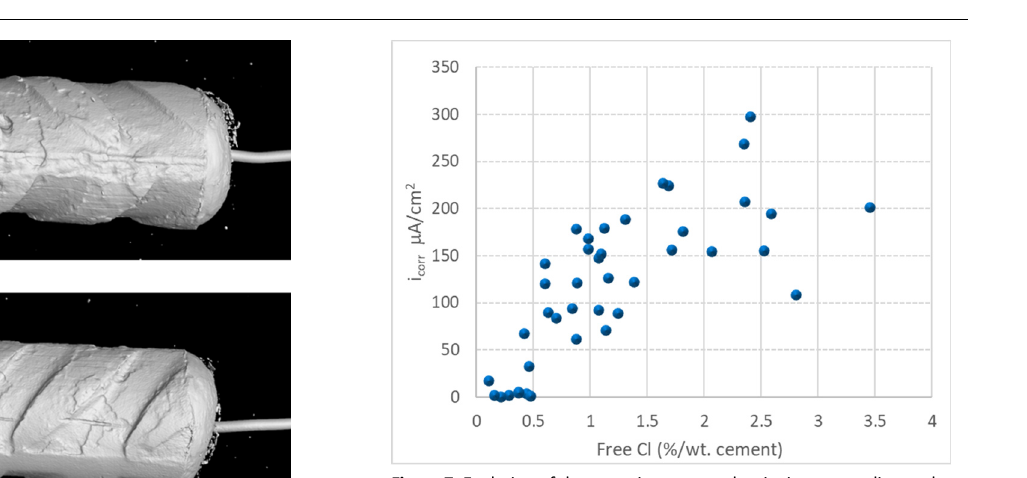
Figure 7. Evolution of the corrosion current density icorr according to the free chloride content.